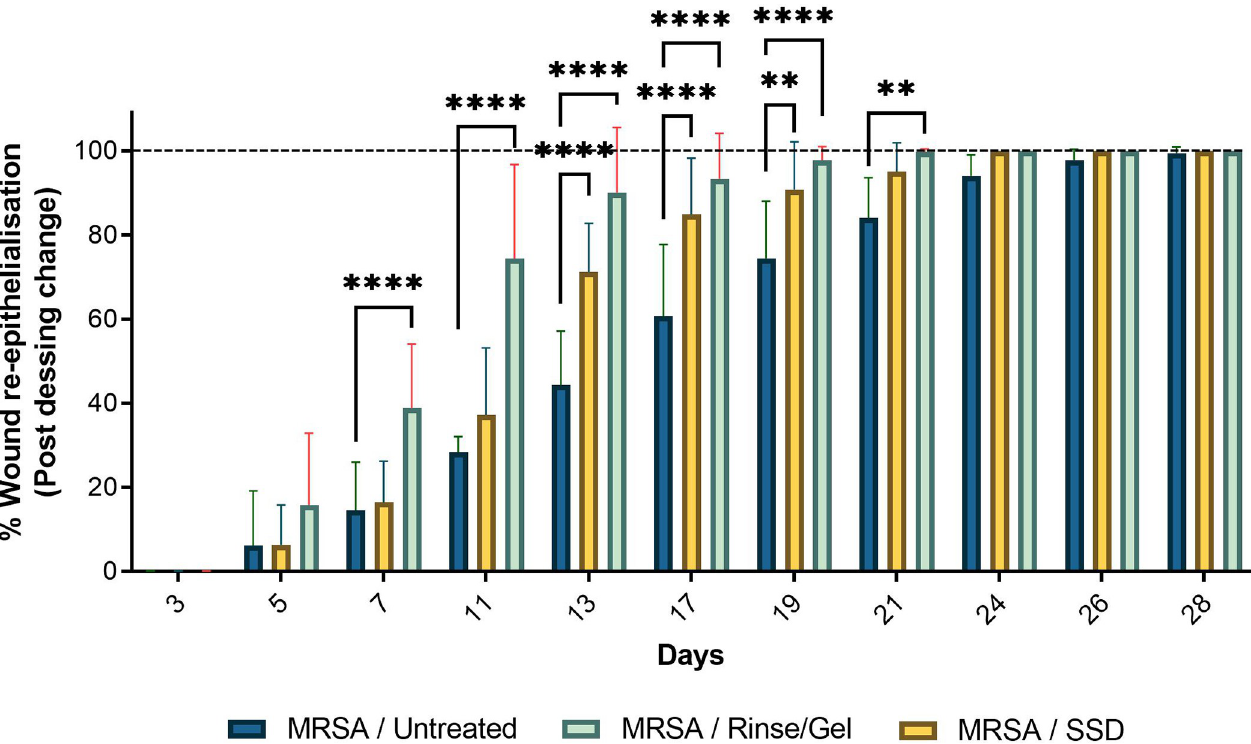
Fig 3. Treatment with wound rinse and wound gel improved healing of MRSA-infected partial-thickness burn wounds. Wound rinse/gel treatment accelerated the rate of wound closure compared to the silver sulfadiazine (SSD) and to untreated controls in MRSA-infected partial-thickness burn wounds. % , percentage; � , p < 0.05; �� , p < 0.01; ��� , p < 0.001; ���� , p < 0.0001. Red ( � )—statistical significance compared to SSD, and Black ( � )- statistical significance compared to MRSA infected untreated.